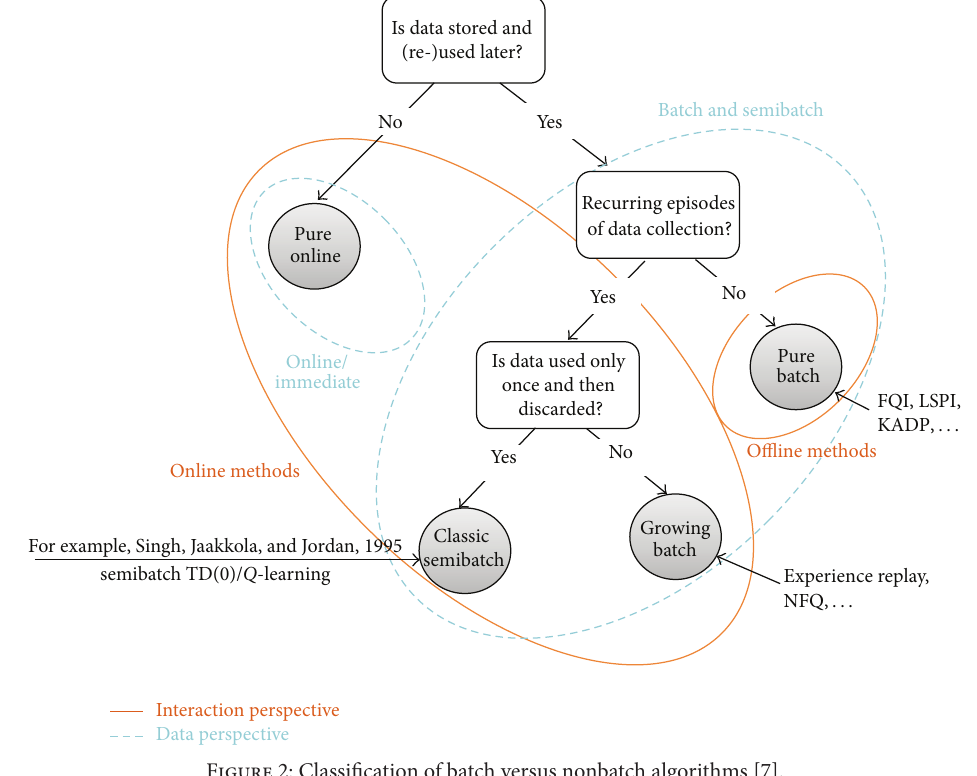
Figure 2: Classification of batch versus nonbatch algorithms [7].